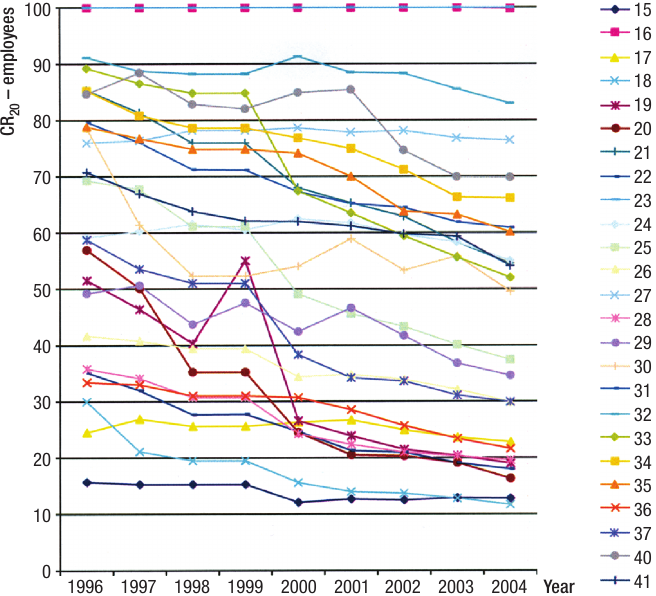
Fig. 5. CR evolution – number of employees during 20 Table 3. Classifying competition in Romania considering the value of the concentration coeffi cients CR value Type of competition Class Reduced degree of concentration 1 Very high degree of concentration or monopoly Table 4 . The distribution of the sectors of activity considering the value of the concentration coeffi cients Number of sectors